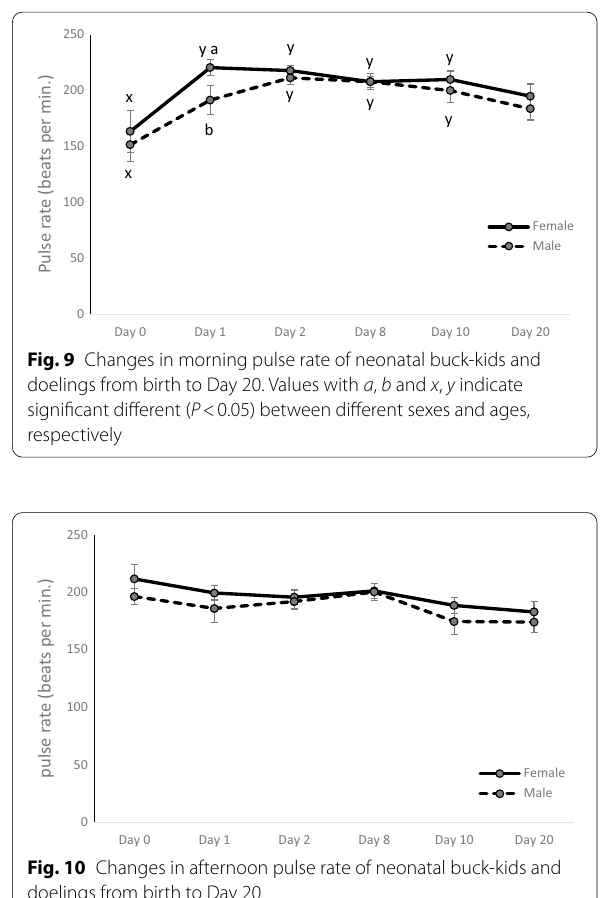
Table 4 Pearson’s correlation between respiratory and pulse rate in neonatal Nigerian goats from birth to Day 20